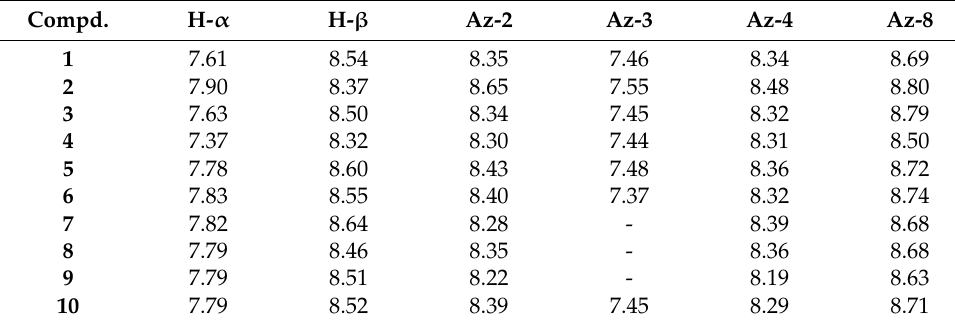
Table 3. Relevant 1 H-chemical shifts for azulene-containing chalcones.